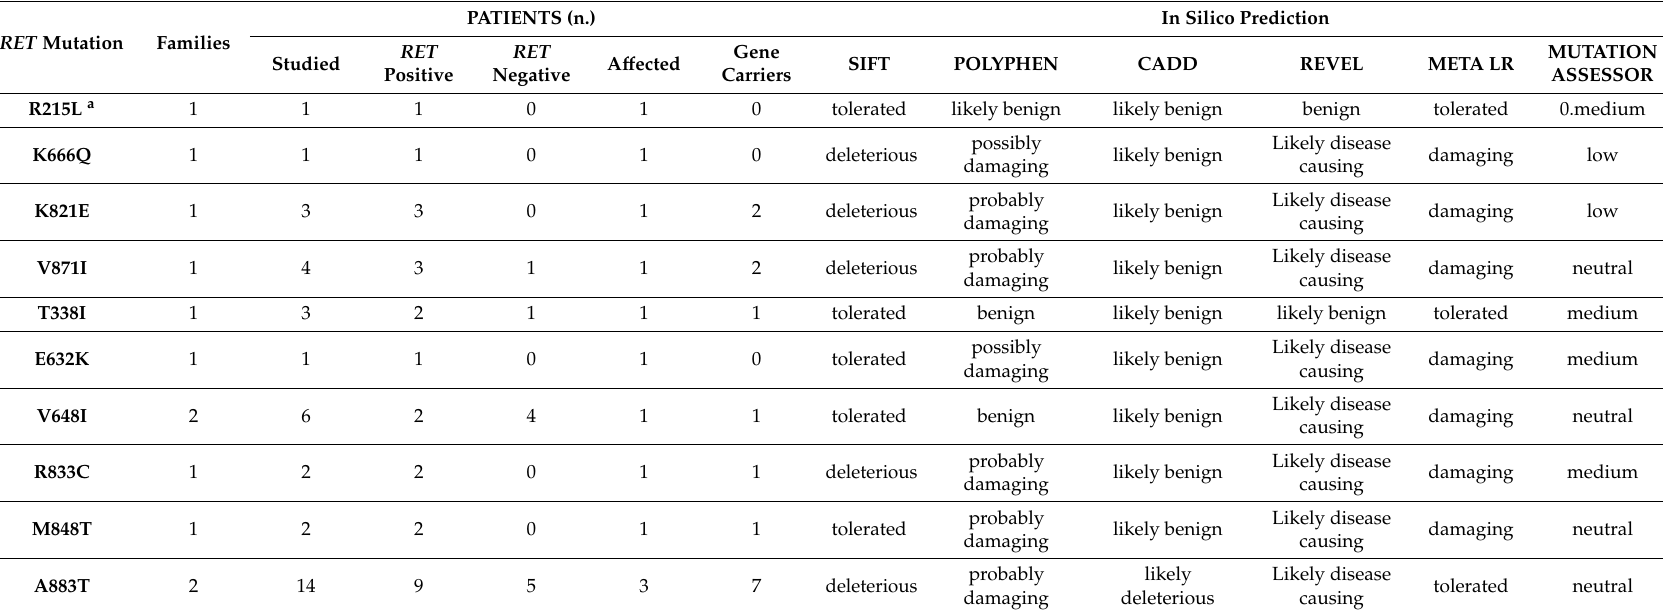
Table 1. Variant of unknown significance: Prevalence in our series and in silico prediction of their transforming